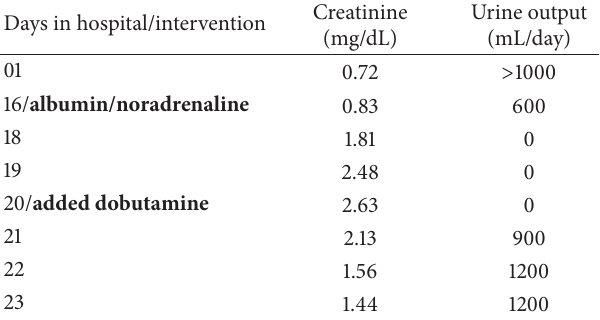
Table 1: Chronologic evolution of serum creatinine and urinary output, in relation to the therapeutic